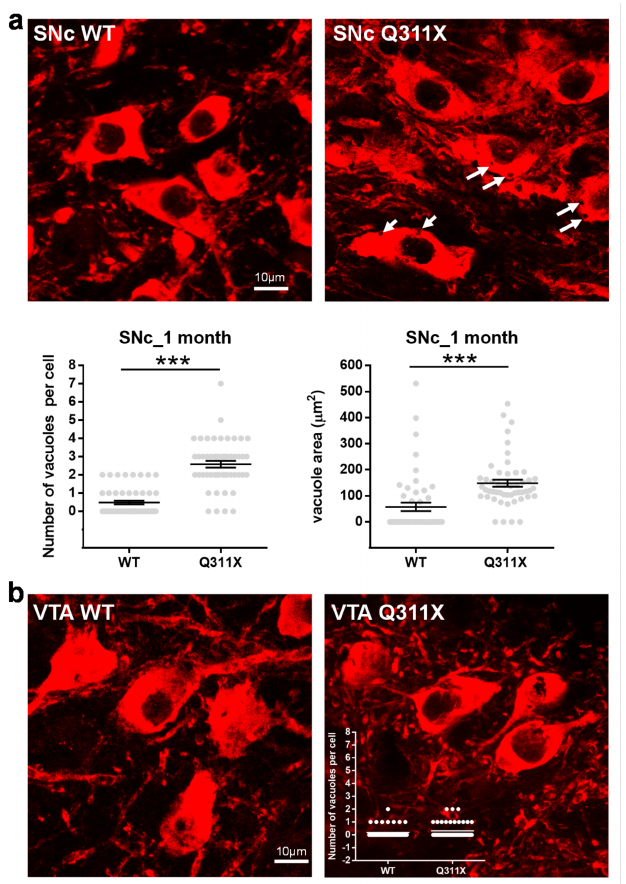
Figure 4. SNc DA neurons in parkinQ311X mice display cytoplasmic vacuolization. ( a ) Representa- tive images showing DA neurons (TH labelling) in the SNc of WT and parkinQ311X mice at 1 month of age. The white arrows indicate the vacuoles in the cytoplasm of DA neurons. The graphs below the images show the number of vacuoles and vacuole area. Data are the mean ± SEM of the number of vacuoles per cell and are derived from n = 3 mice per genotype: WT 1M SNc 0.49 ± 0.11, parkinQ311X 1M SNc 2.59 ± 0.19 ( n = 51 cells analyzed for each genotype, Mann–Whitney U test, *** p < 0.001). ( b ) Representative images showing DA neurons of the ventral tegmental area. One to two vacuoles per cell were observed in a small subset of DA neurons of the ventral tegmental area in WT and parkinQ311X mice, but no difference between the two genotypes was